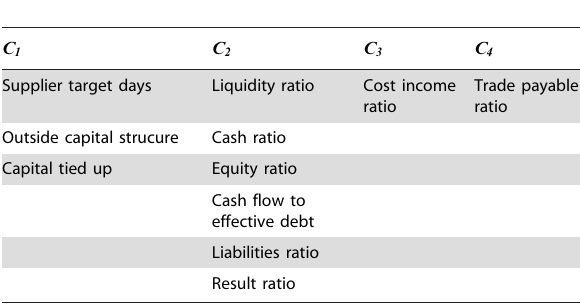
Table 6. NetSel communities extraction result on the proposed set of financial ratios.